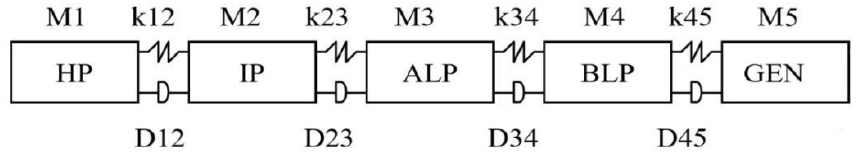
Figure 1. Turbo-generator with multiple degrees of freedom system.